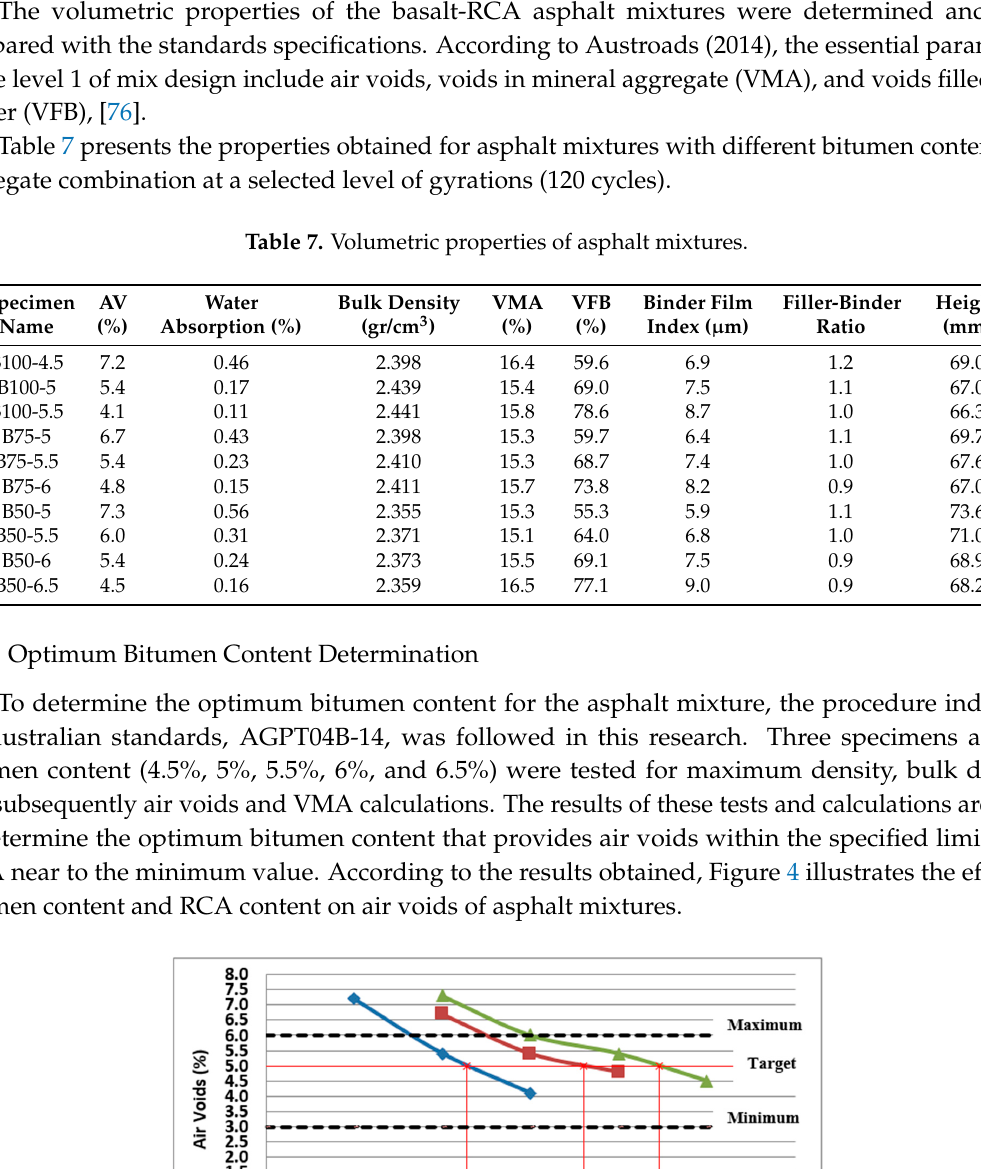
Table 6. Test Results for Evaluation of Fine Aggregate Properties.